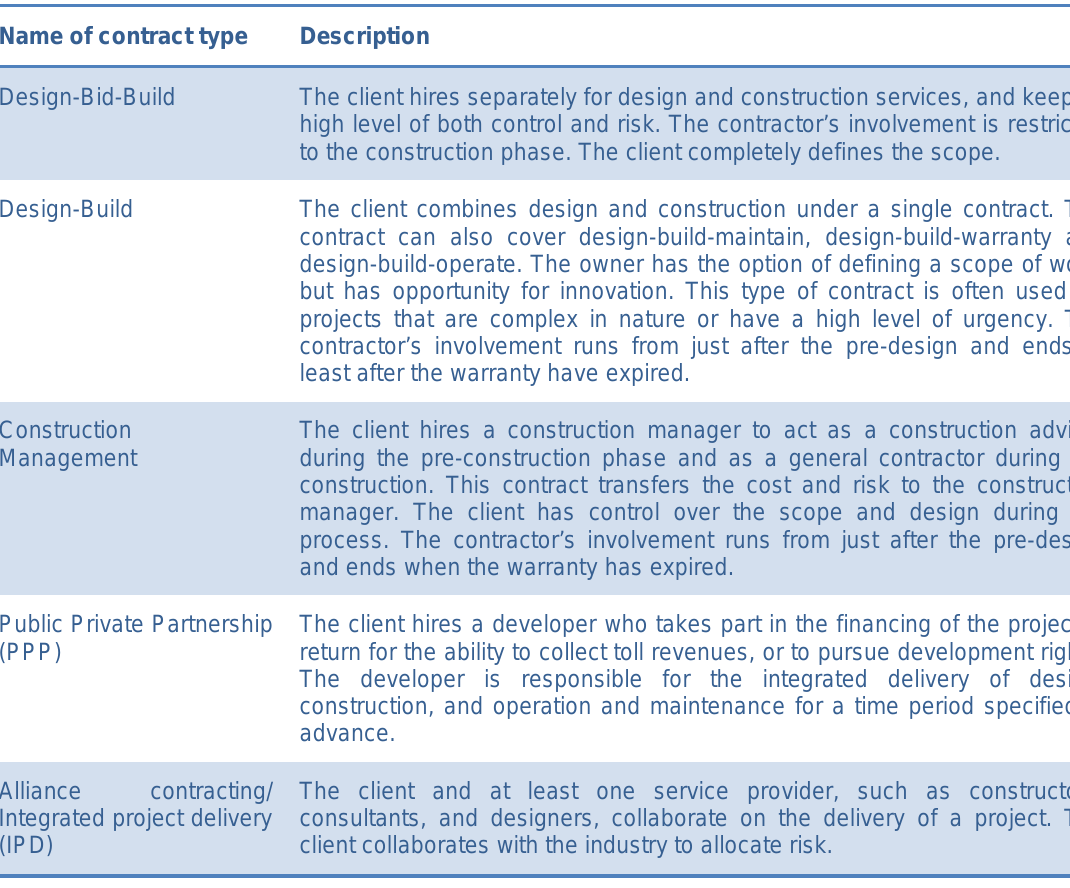
Table 4: Contract structure in FHWA